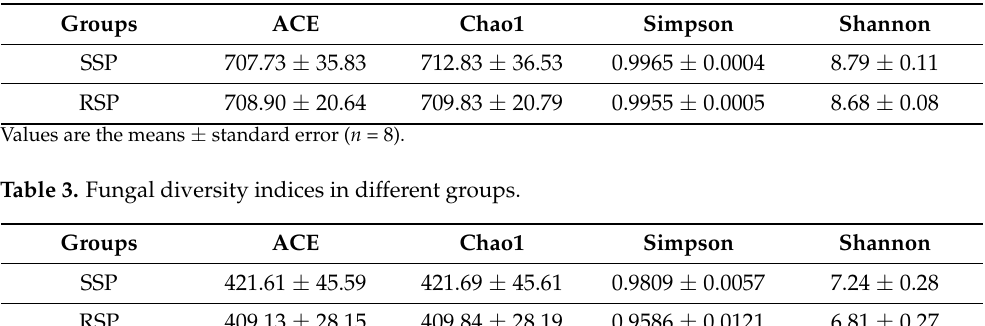
Table 2. Bacterial diversity indices in different groups.